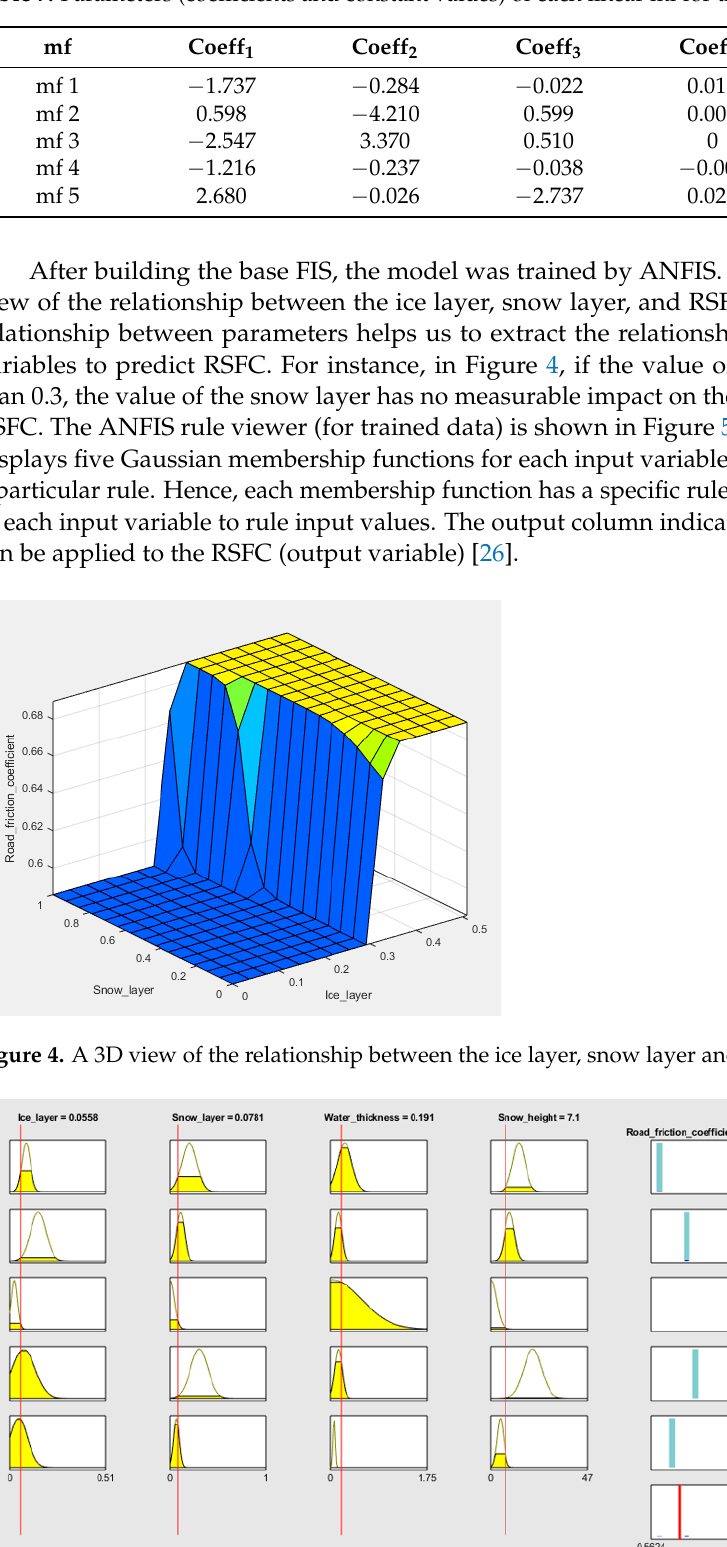
Table 7. Parameters (coefficients and constant values) of each linear mf for the output.